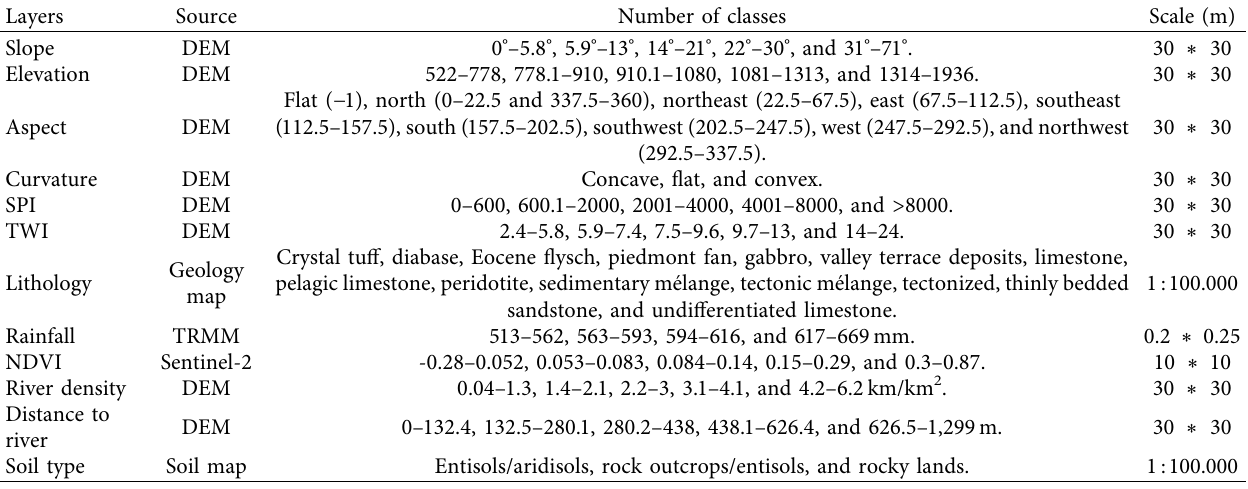
Table 1: The floods-affecting parameters, source, classes, and scale.